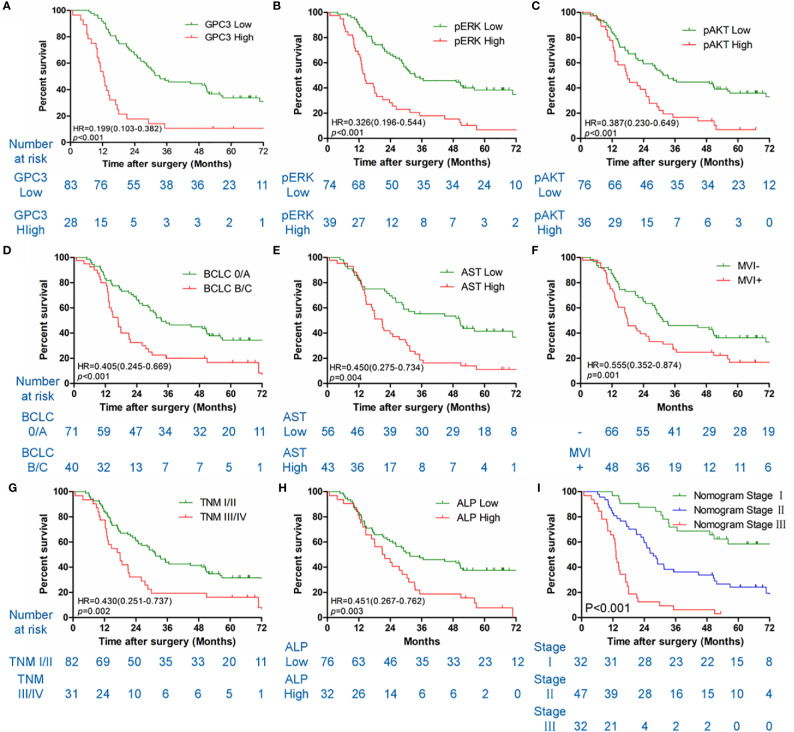
Kaplan-Meier survival curves of OS in the sorafenib cohort. GPC3 (A), pERK (B), pAKT (C), BCLC staging system (D), serum AST (E), MVI (F), TNM stage (G), serum ALP (H) and nomogram stage (I) of sorfenib cohort.